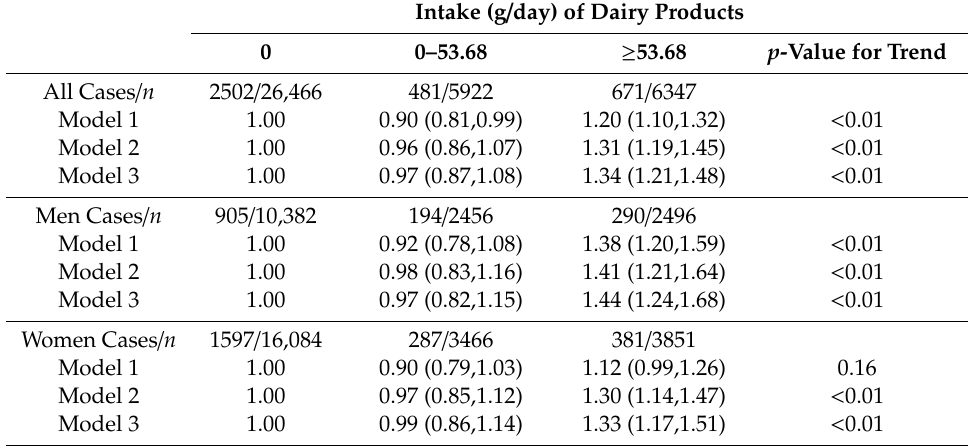
Table 3. ORs of T2DM according to the intake of dairy products ( n = 38,735) of the Henan Rural Cohort